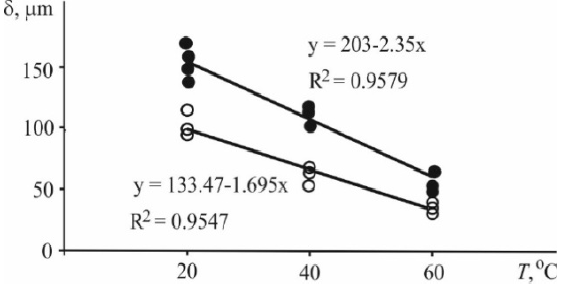
metal) 5. APPLICATION OF THE CHEMOGRAPHY